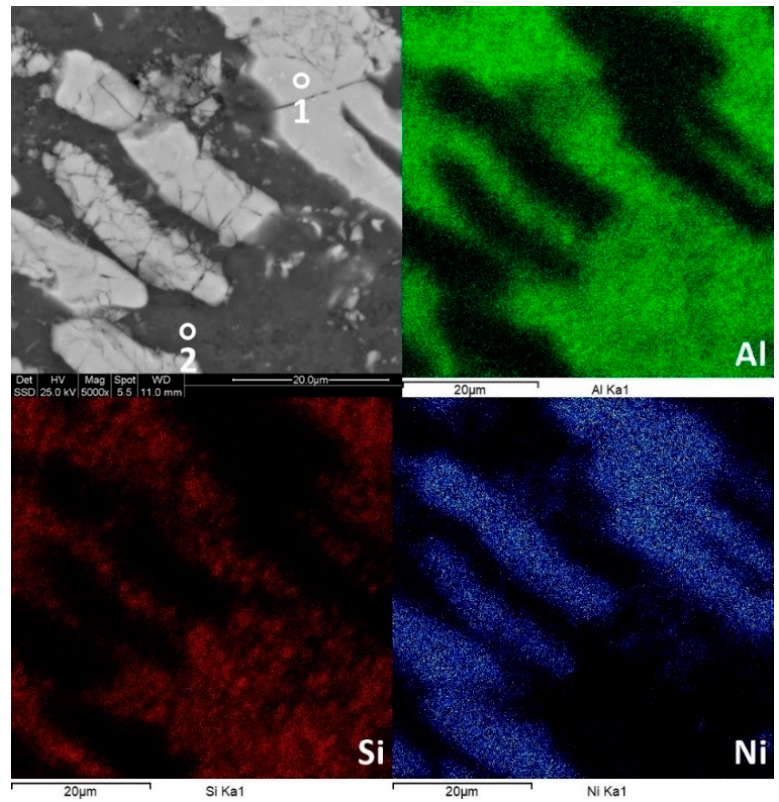
Figure 6. Surface morphology and chemical composition of Al 79 Si 11 Ni 10 in bulk form. The segregation of the elements is noticeable, and it is linked to the structural development of the alloy.